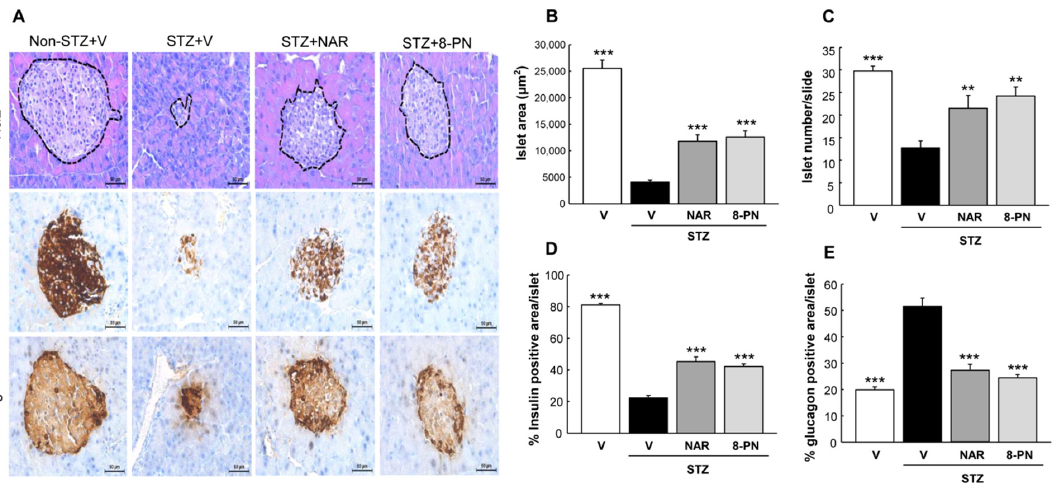
Figure 2. Protective effects of naringenin and 8-PN against islet dysfunction. ( A ) H&E and DAB staining for insulin and glucagon were performed to analyze histopathological changes in pancreatic islets (×400) at the end of study. H&E-stained sections were analyzed for the measurement of ( B ) islet area and ( C ) islet number using ImageJ software. Quantitative data of ( D ) insulin and ( E ) glucagon signals were calculated by dividing the area of target signal by the total islet area, for at least 10 islets per mouse. V, vehicle; NAR, naringenin; 8-PN, 8-prenylnaringenin. Data are shown as means ± SEM (n = 4). ** p < 0.01, *** p < 0.001 vs. STZ vehicle